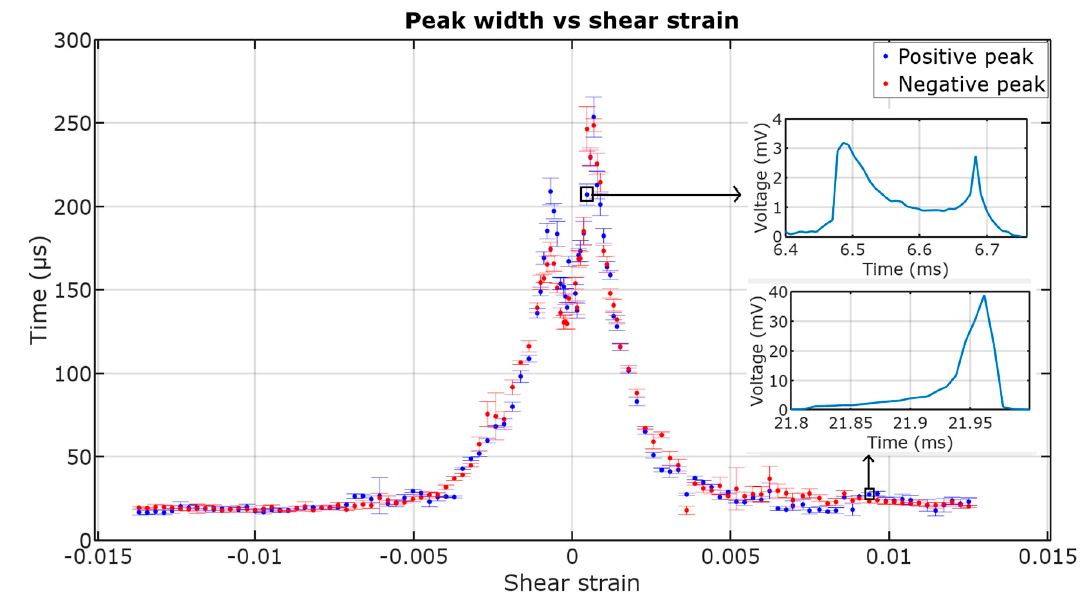
Figure 8. Dependence of the ME peaks’ width on shear strain ( ± 1 std. deviation, insets show the voltage signal vs. time plot for two exemplary points—low shear strain and high shear strain region).